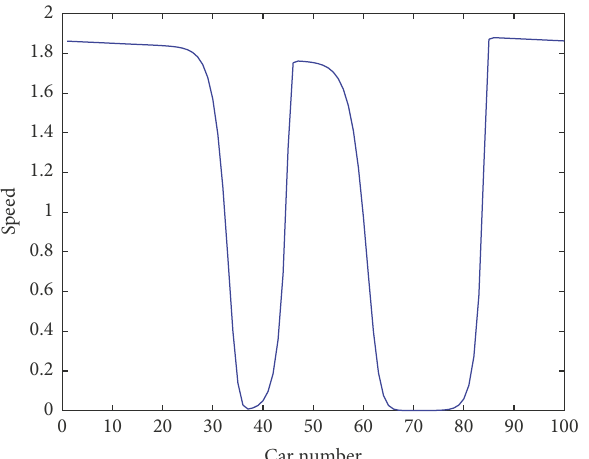
Figure 5: Speed profiles for DSDM with 𝛼 = 0.4 , 𝑇 𝑠 = 0.9 at 𝑡 = 300s.